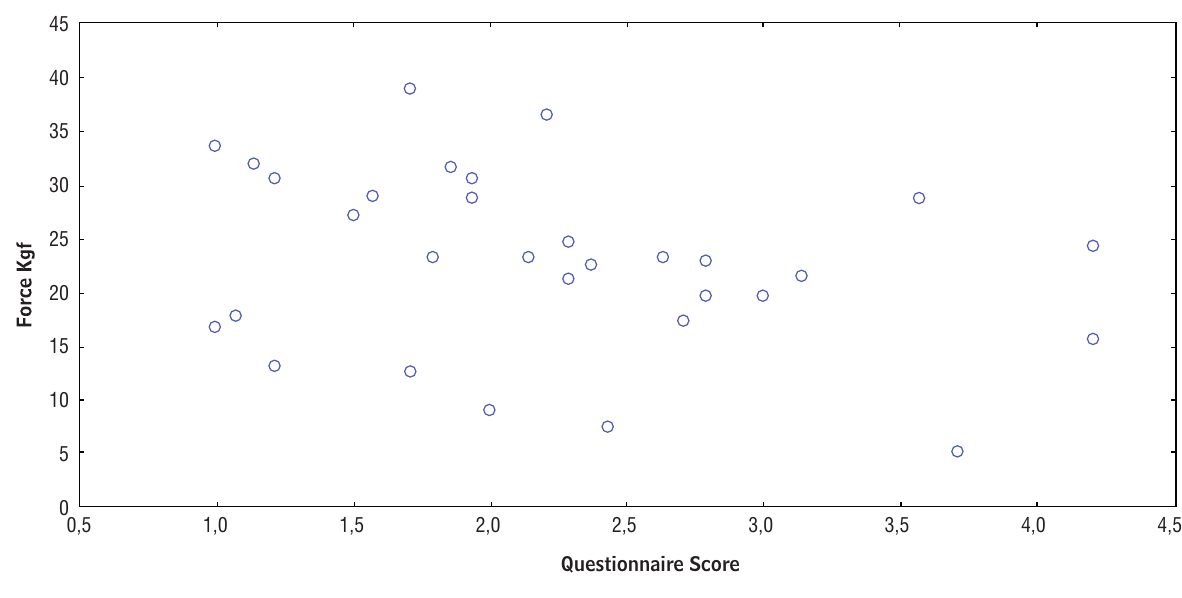
Figure 1 - Scatter plot correlation between grip force (kgf) and scores of fatigue questionnaire